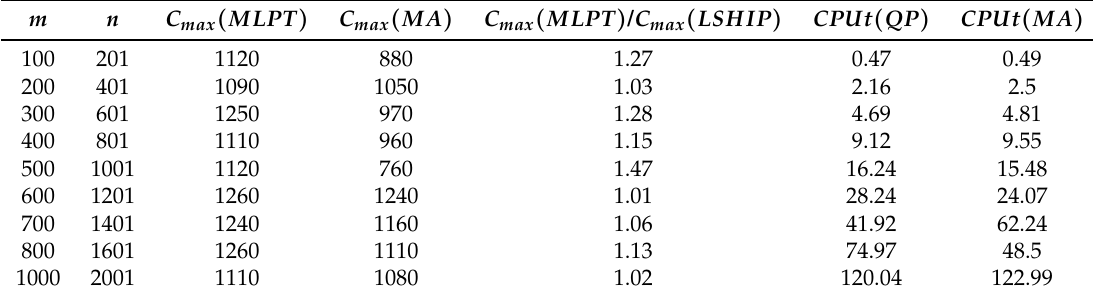
Table 8. Comparison of MA and MLPT